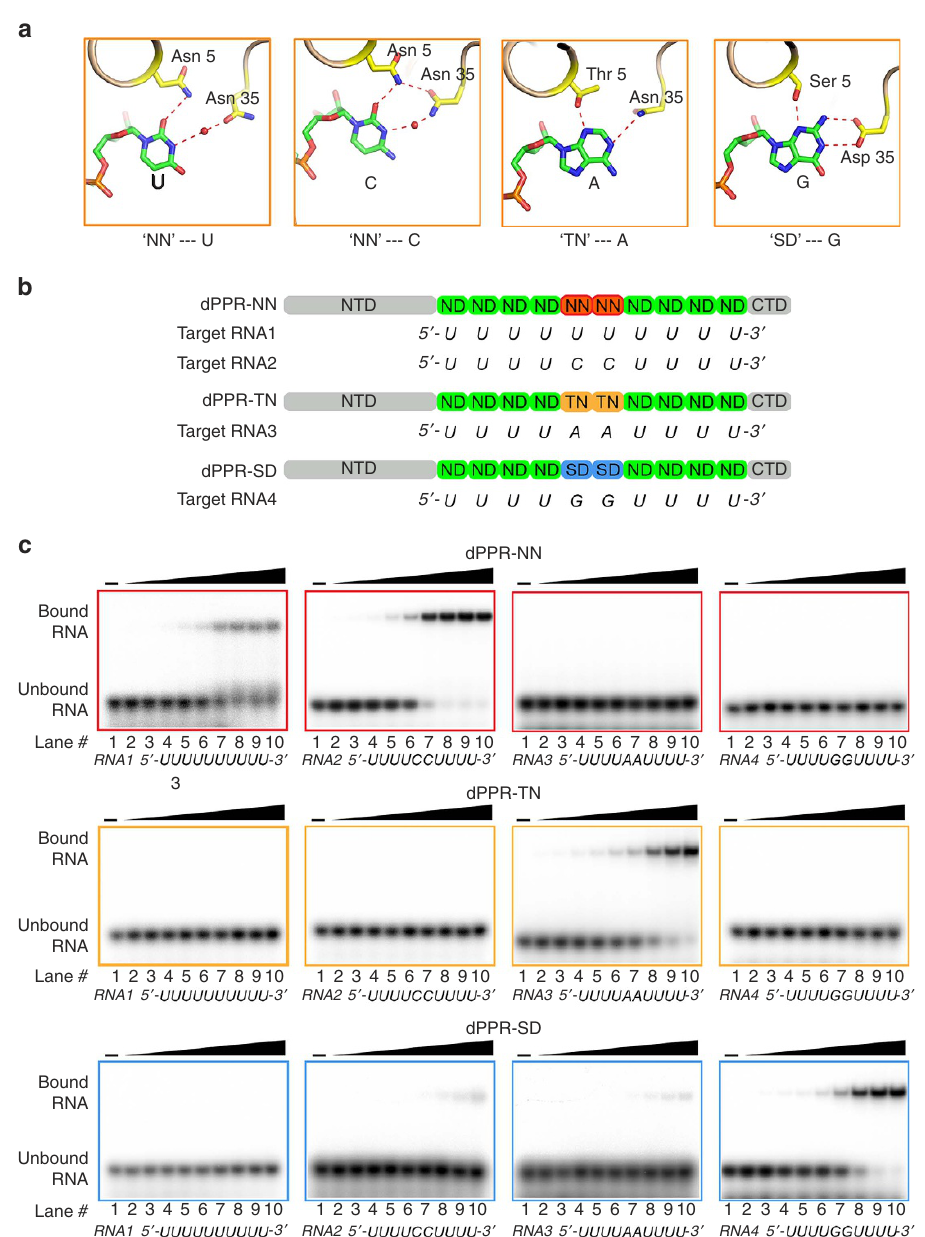
Figure 5 | Interaction models for more PPR codes. ( a ) Prediction of another 4 interaction models for PPR codes ‘NN’, ‘TN’ and ‘SD’ with U, C, A and G, respectively. The hydrogen bonds are represented by red dotted lines. Water molecules are represented by red spheres. ( b ) Schematic representation of dPPR-NN, dPPR-TN, dPPR-SD and their target RNA sequences. The shaded binary amino acids are indicative of PPR repeats with different codes. NTD and CTD are from native PPR10. ( c ) EMSA demonstrates the specific RNA recognition of dPPR proteins with predicted codes. The final concentrations of dPPR in lanes 1–10 are 0, 0.8, 1.6, 3.2, 6.25, 12.5, 25, 50, 100 and 200nM, respectively. The detailed K d values are shown in Supplementary Table 1. Data collection and structural determination . All data sets were collected at SSRF beamline BL19U or BL17U and processed with the HKL3000 or HKL2000 packa- ges 48 . Further processing was performed with programs from the CCP4 suite 49 . Data collection and structure refinement statistics are summarized in Table 1. The structure of the dPPR–RNA complex was solved by MR with the newly solved RNA- free structure as the search model using the programme PHASER 50 . The structure was manually iteratively refined with PHENIX and COOT 51,52 (Table 1). Electrophoretic mobility shift assay (EMSA) . The ssRNA oligonucleotides were radiolabelled at their 5 0 ends with [ g - 32 P] ATP (PerkinElmer), catalysed by T4 polynucleotide kinase (Takara). For EMSA, dPPR proteins were incubated with B 2nM 32 P-labelled probe in final binding reactions containing 25mM Tris–HCl, pH 8.0, 5mM MgCl 2 , 5mM 1,4-dithiothreitol, 0.1mgml (cid:2) 1 bovine serum albumin, 50ngml (cid:2) 1 heparin and 10% glycerol for 20min on ice. The reactions were then NATURE COMMUNICATIONS|7:11285|DOI: